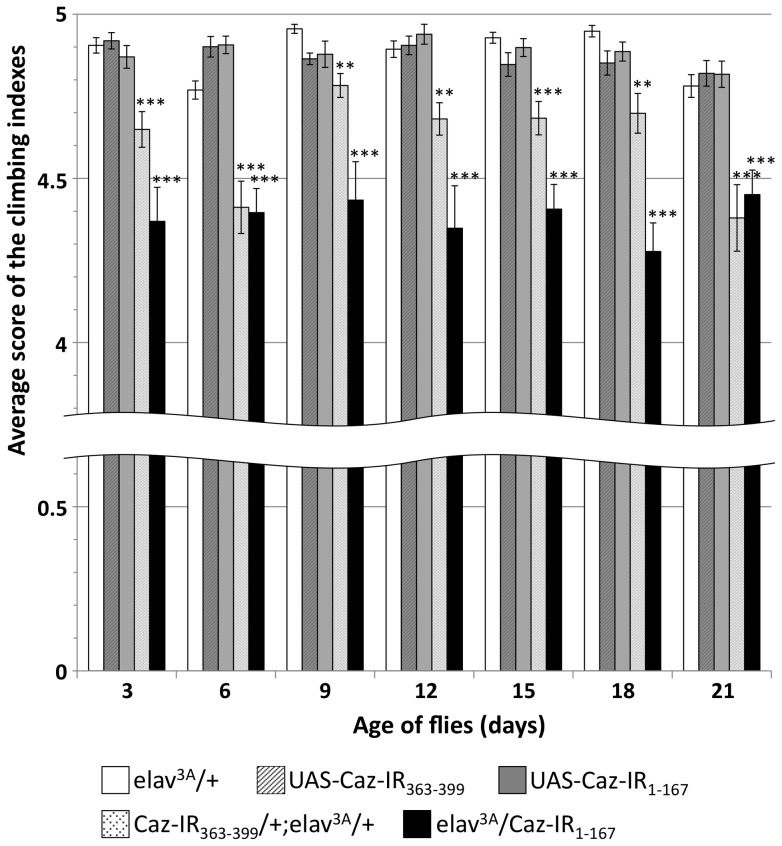
Climbing assays.Five independent tests were performed for each genotype. The total number of flies counted was: elav3A/+ (a driver control, n = 309), UAS-Caz-IR363-399/+ (a responder control, n = 222), UAS-Caz-IR1-167/+ (a responder control, n = 246), Caz-IR363-399/+;elav3A/+ (n = 265) and elav3A/Caz-IR1-167 (n = 238). There was no significant difference in climbing abilities between the driver and responder control flies in each day after eclosion. Flies carrying elav3A/Caz-IR1-167 or Caz-IR363-399/+;elav3A/+ showed a significantly reduced ability to climb upwards compared to elav3A/+ flies in each examined day. The horizontal bars indicate standard errors of mean values. ***p<0.001, **p<0.005.